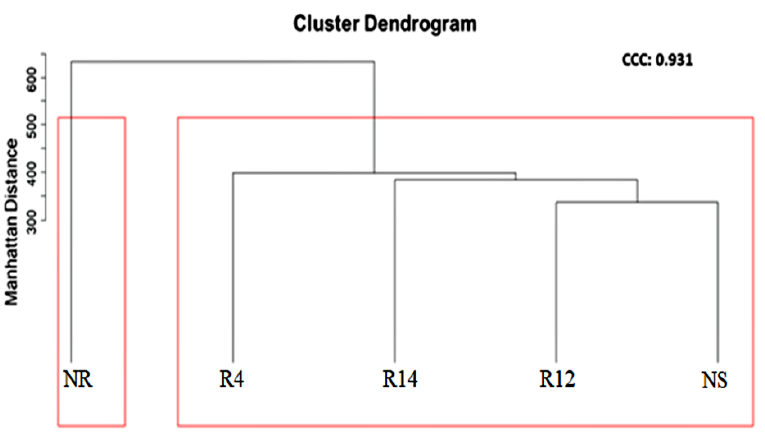
Figure 6. Area clustering based on enzyme abundance distributed in EC number subclasses (level 2) was built with the Manhattan distance index using the hclust function in R software. A cutoff was determined to separate the areas into two groups. Cophenetic correlation coefficient = 0.931.